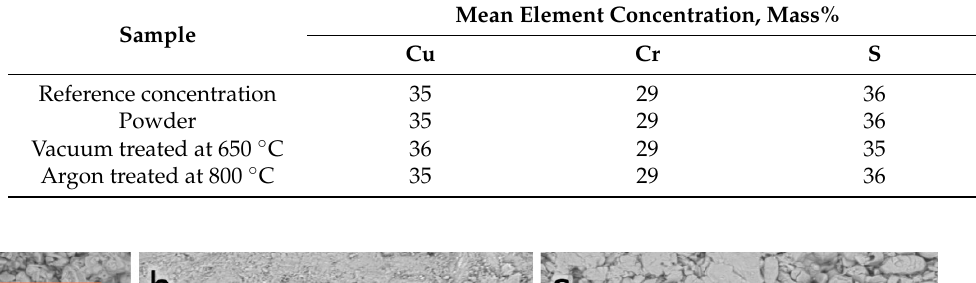
Table 2. Elemental composition of synthesized CuCrS 2 powder and ceramic samples.